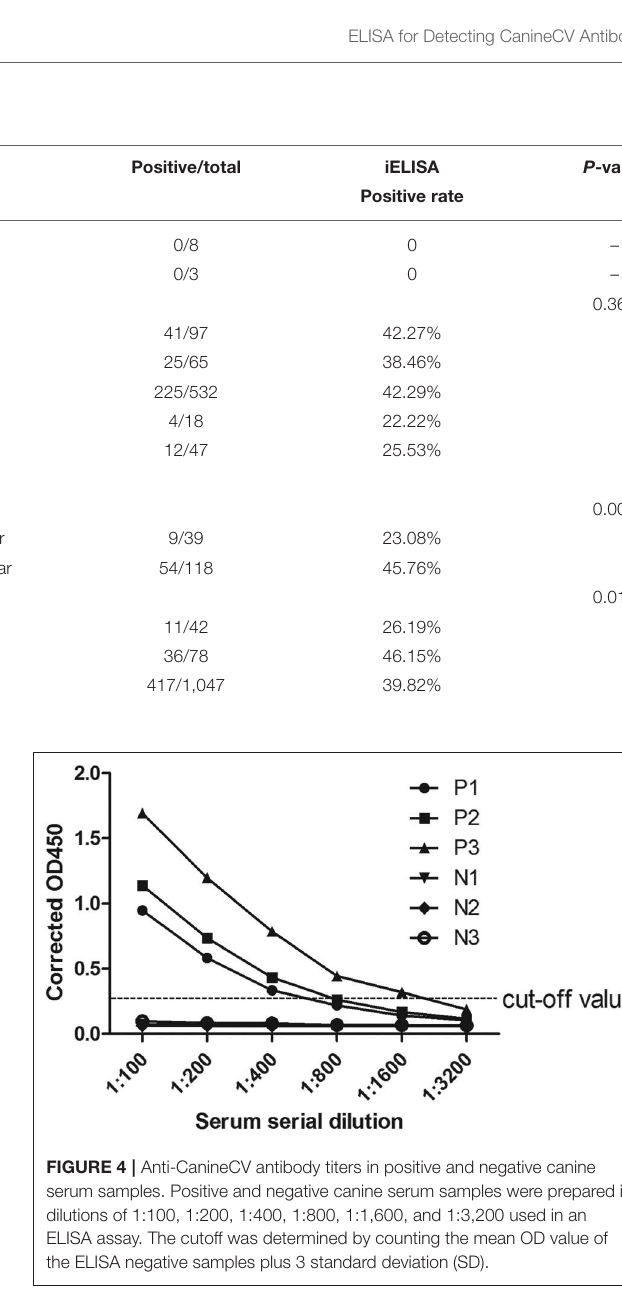
was calculated. Among the 42 dogs < 3 months old, 26.19% is CanineCV antibody-positive, while 36 (46.15%) in the 78 sera from > 1-year-old dogs are positive. Statistical analysis shows a significant difference in age between dogs < 3 months old